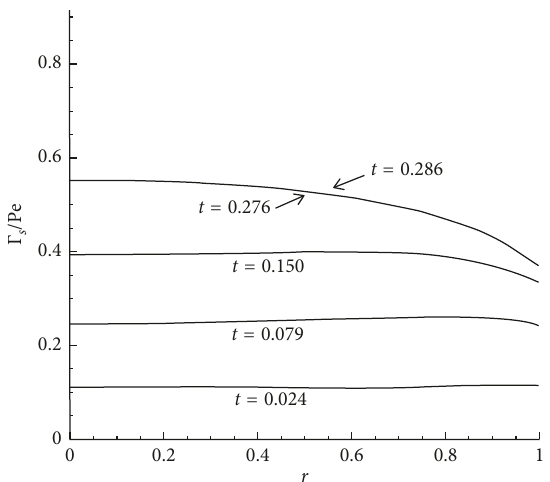
Figure 6: Evolution of the particle deposition for Pe � 1 and Da � 10. Initial AR � 0.8, Ca � 8.41 × 10 − 8 .